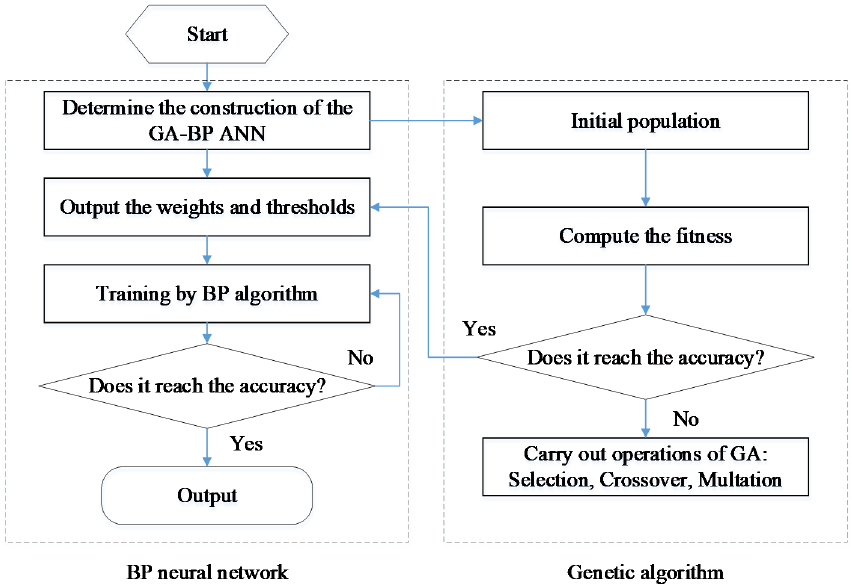
Figure 12. The flow diagram of genetic algorithm back propagation artificial neural network (GA-BP ANN).